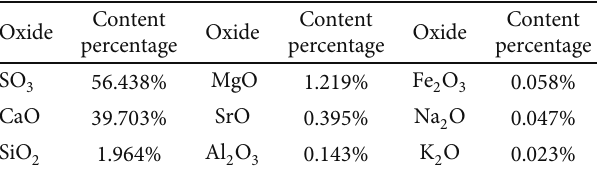
Figure 6: XPS map of gypsum rocks. Table 2: Percentage of oxide content in gypsum